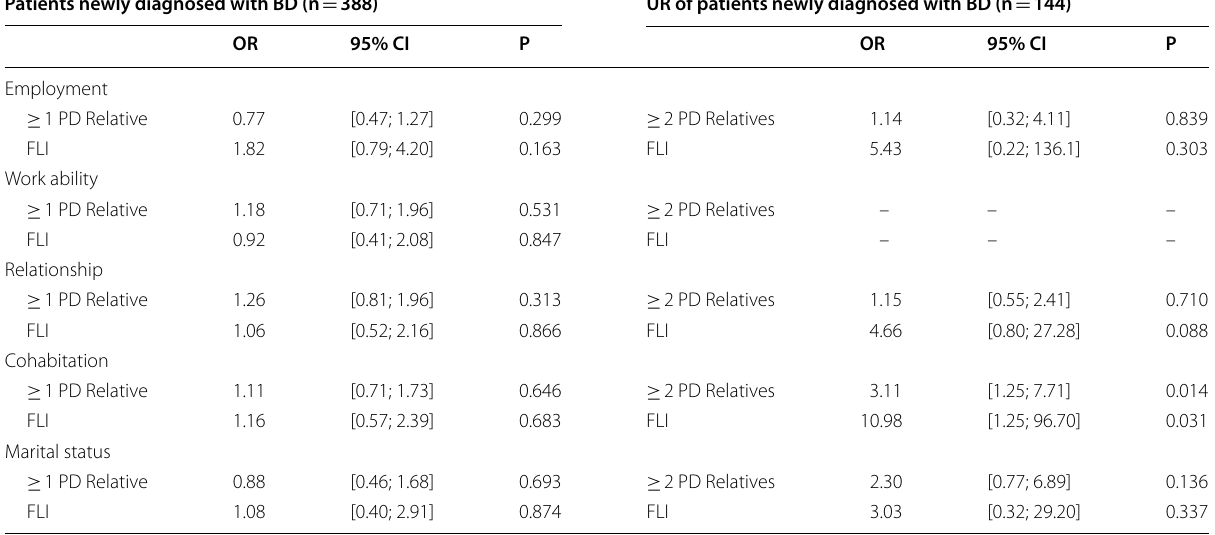
Table 4 Associations between familial load of psychiatric disorders (PD) and the outcomes (1) Employment, (2) Work ability, (3) Relationship, (4) Cohabitation and (5) Marital status in patients newly diagnosed with bipolar disorder (BD) and their unaffected first- degree relatives